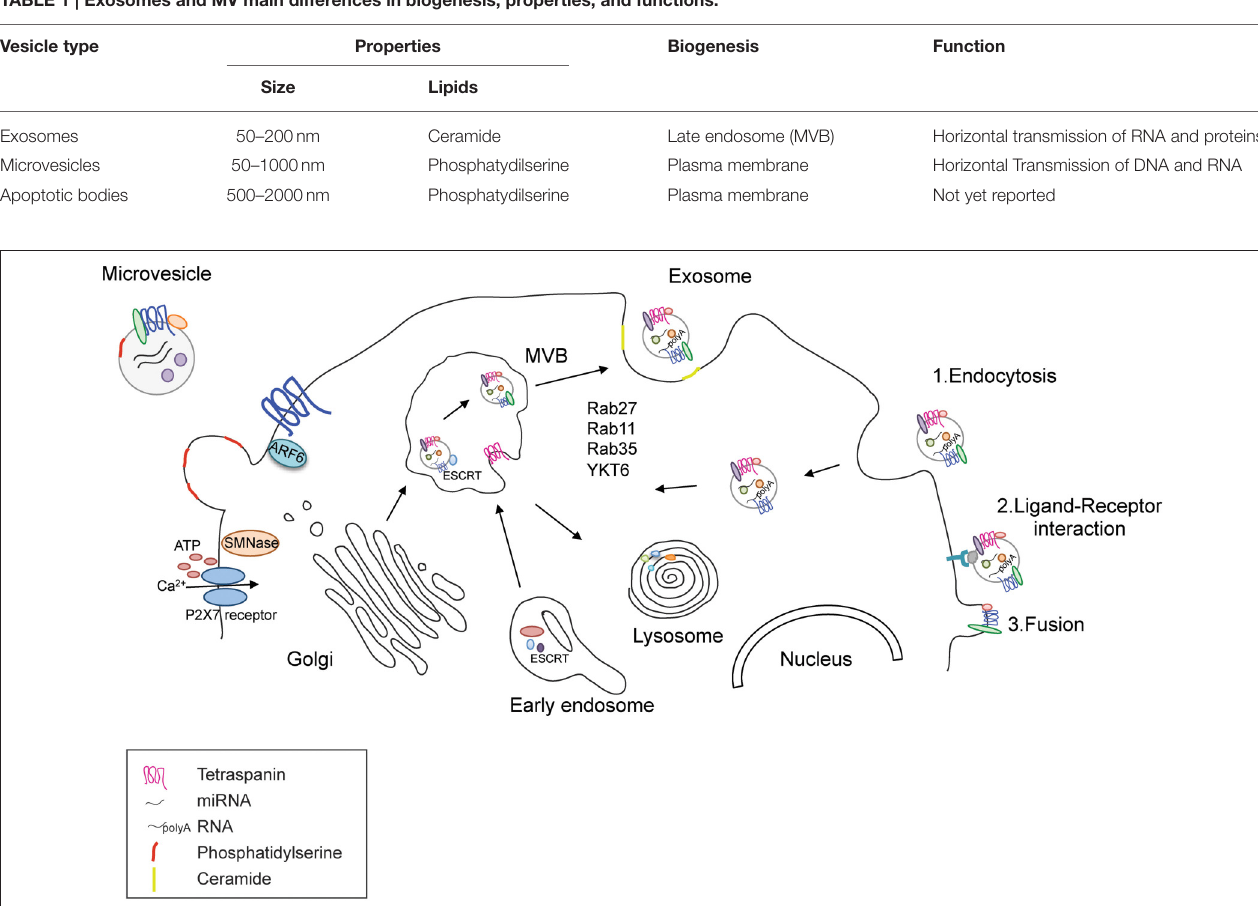
TABLE 1 | Exosomes and MV main differences in biogenesis, properties, and functions.